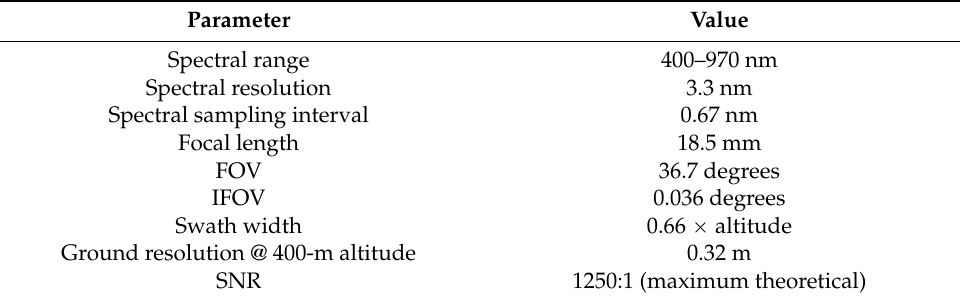
Figure 2. Experimental setup. ( a ) airship; ( b ) AisaEAGLE airborne Hyperspectral Imaging System; ( c ) reference white board; ( d ) CE318. Table 3. The AisaEAGLE sensor parameters.